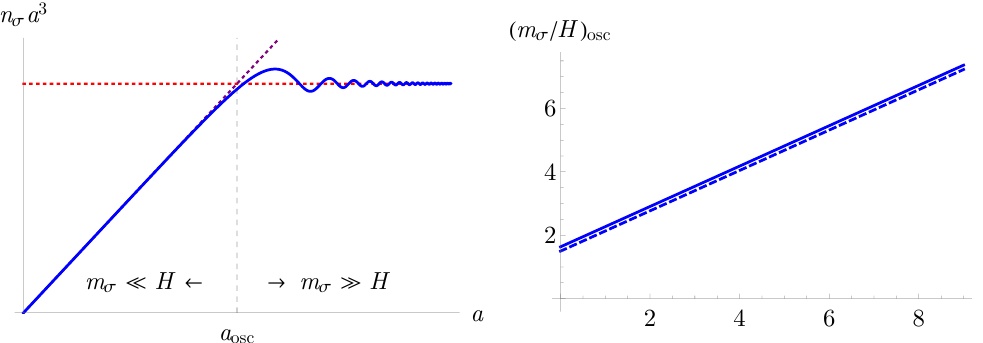
Figure 5 . Left: Time evolution of the axion’s comoving number density in terms of the scale factor, in log-log scale. The dotted lines show the limiting behaviors in the asymptotic past and future. The onset of the axion oscillation is de(cid:12)ned as when the limiting forms cross each other (see the text for details). Right: Ratio between the axion mass and the Hubble scale at the onset of the axion oscillation, as a function of the power p of the temperature dependence. The equation of state of the universe is taken as w = 1 = 3 (solid line) and w = 0